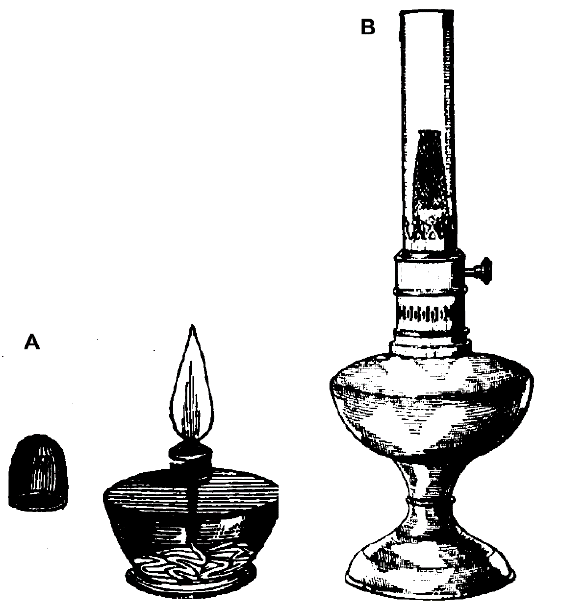
Figure 7. A simple spirit lamp, circa 1830 (A) and an incandescent alcohol lamp, circa 1900 (B).